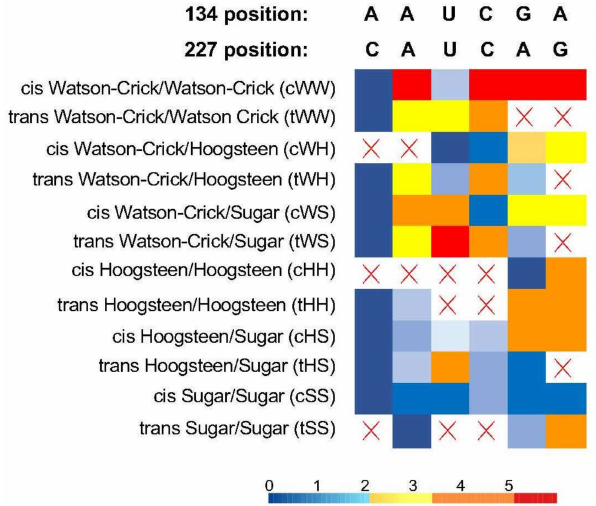
Figure 2. The heat map view of structural similarity among six function loop 19 variants. Red crosses dictate that the structures cannot form using this base pairing geometry. The numeric value in the IsoDiscrepancy Index heat map: values less than 2.2 are in blue color depicting isosteric base pairings; values between 2.2 and 3.5 are displayed in yellow color depicting nearly isosteric base pairings; values above 3.5 are colored in orange or red depicting the non-isosteric base